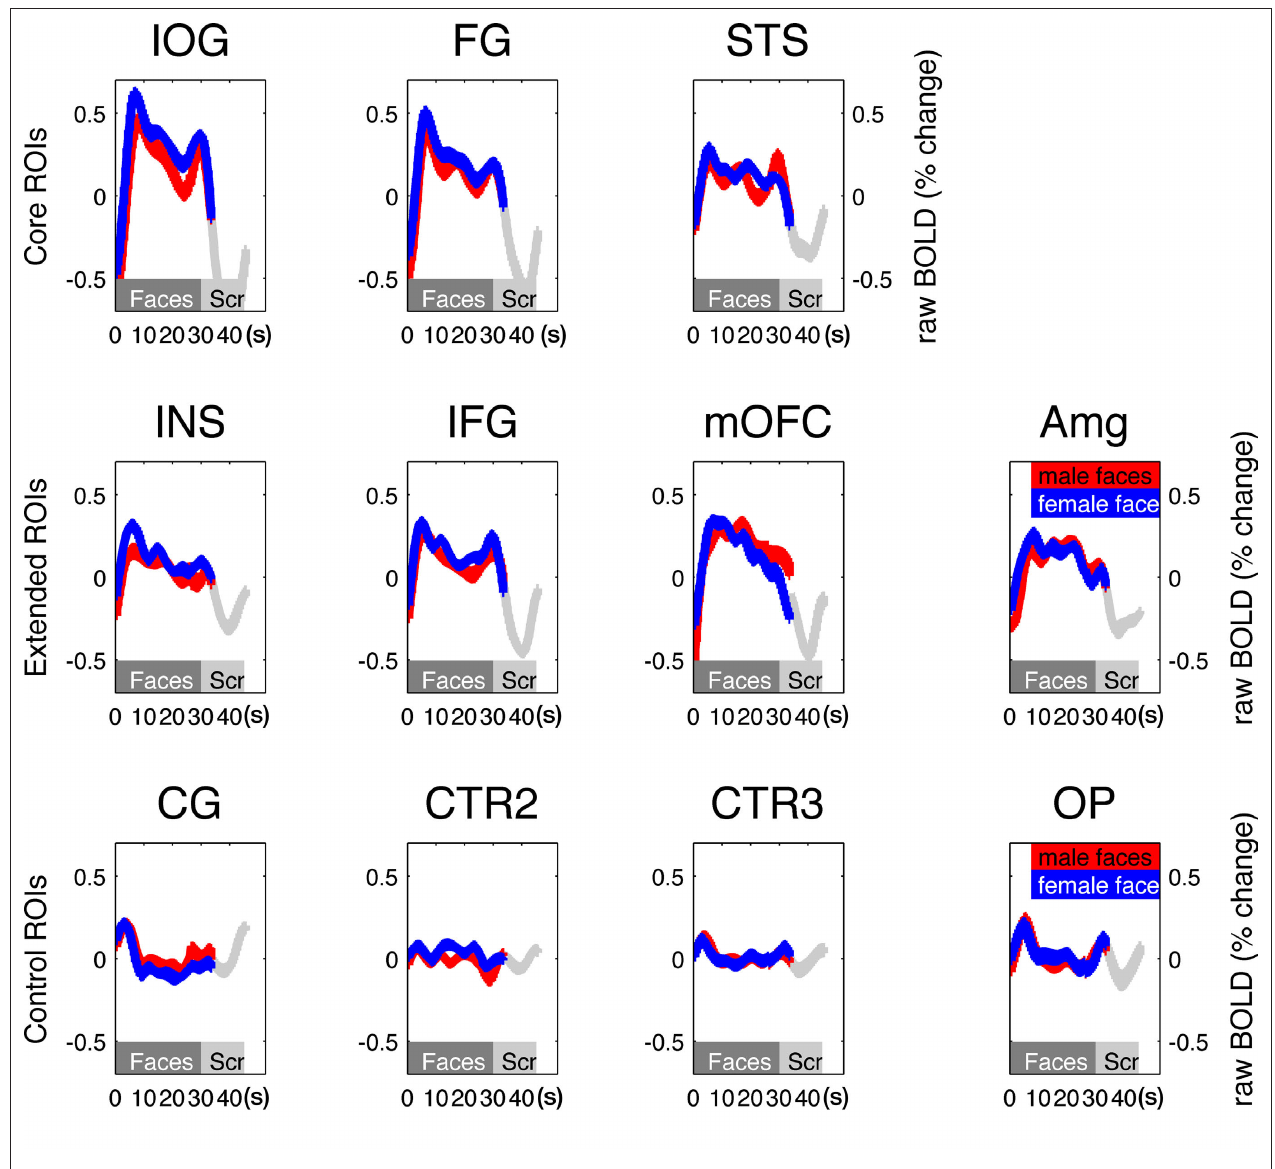
seconds. The gray bar indicates the duration of a 30-s stimulus block, shifted by 6 s to account for the hemodynamic delay. In comparison, control ROIs showed no increased activation in relation to the stimulus blocks. In all ROIs, the difference in response to male and female faces was insignificant (red vs. blue